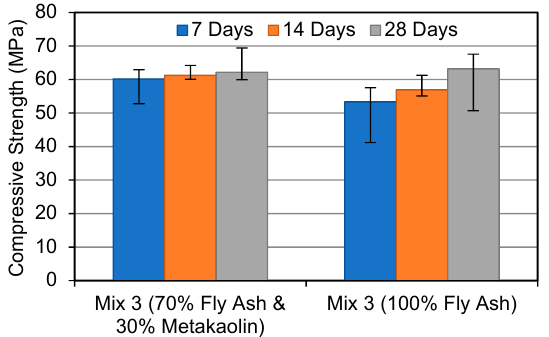
Figure 3. Compressive strength development at alkaline solution molar ratio 2.5.